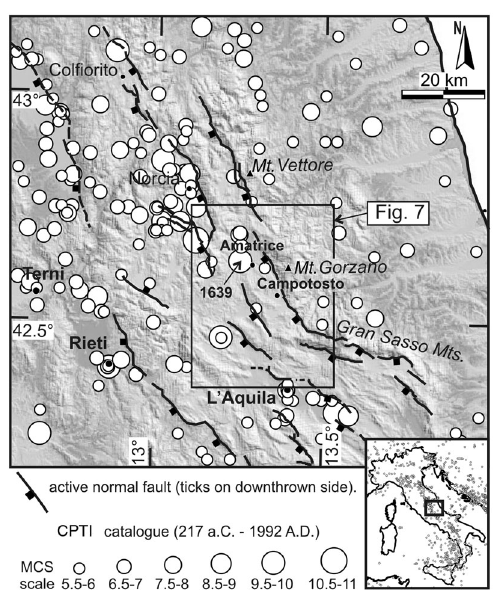
Fig. 1. S haded relief of Central Apennines with ma- jor active normal faults, historical earthquakes from CPTI catalogue (Gruppo di Lavoro CPTI, 1999) and location of the Amatrice-Campotosto area